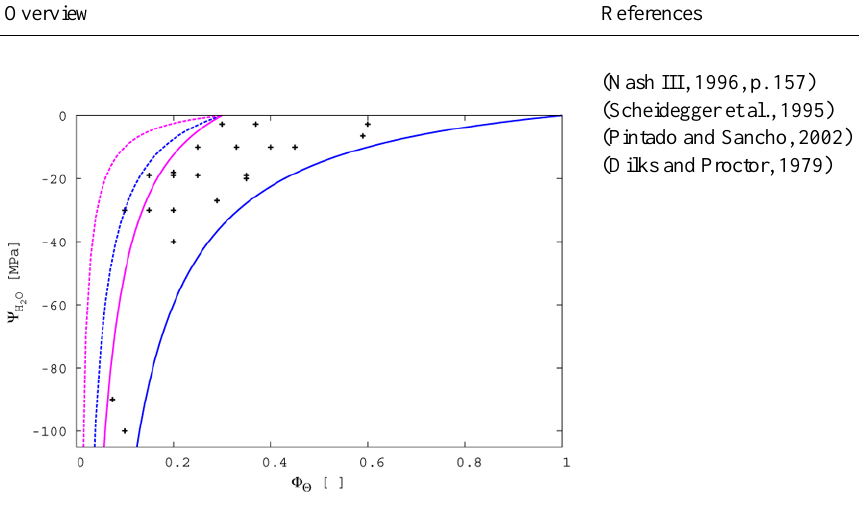
Fig. B3. Water potential 9 H as a function of water saturation 8 2 . Four example curves are shown. The two blue curves correspond to a 2 O = 15 . 0, which represents the middle of the range of possible values. The dashed blue curve corresponds to x 8 value of x 9 H2O = 1 . 0. The two magenta curves correspond to a value of x 2, sat = 0 . 3. The dashed magenta curve corresponds the solid blue curve to x 8 2, sat = 5 . 0 and the solid magenta curve to x 9 = 25 . 0. The black data points are derived from the studies listed in the right column. to x 9 H2O H2O